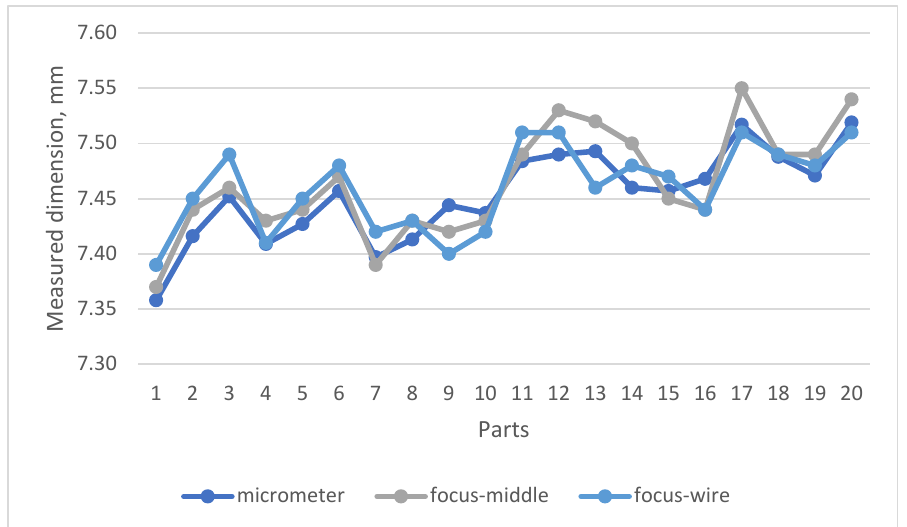
Figure 8. Comparison of measurement results obtained with micrometer and RMS with different focus settings.